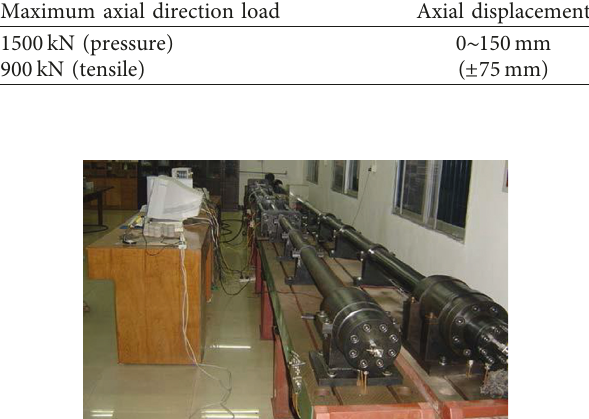
Figure 2: Schematics of SHPB equipment.